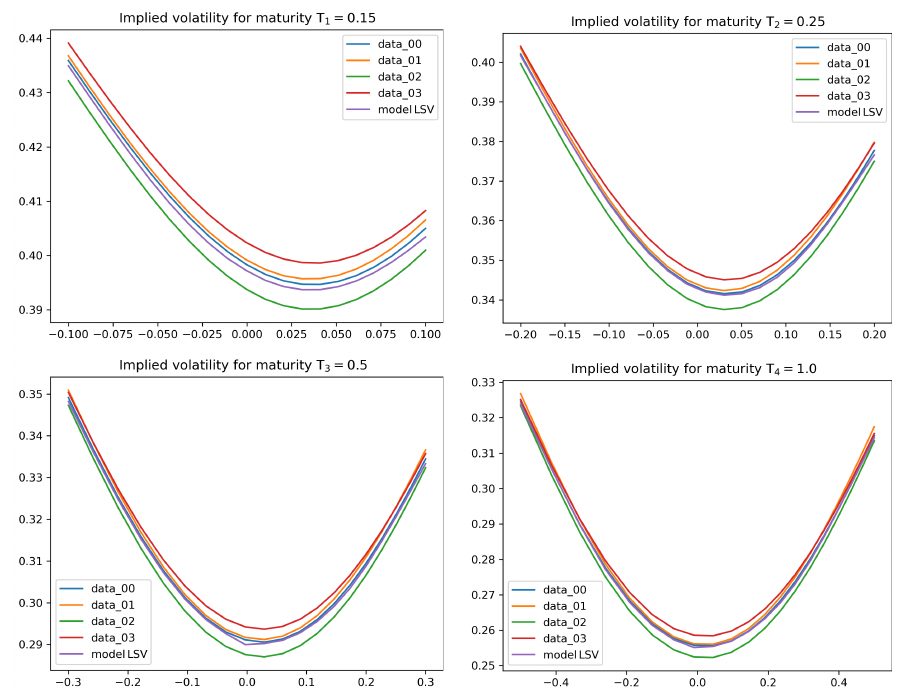
Figure 7. Robust calibration as described in Section 4.3 for all four maturities, the x -axis is given in log-moneyness ln ( K / S 0 )